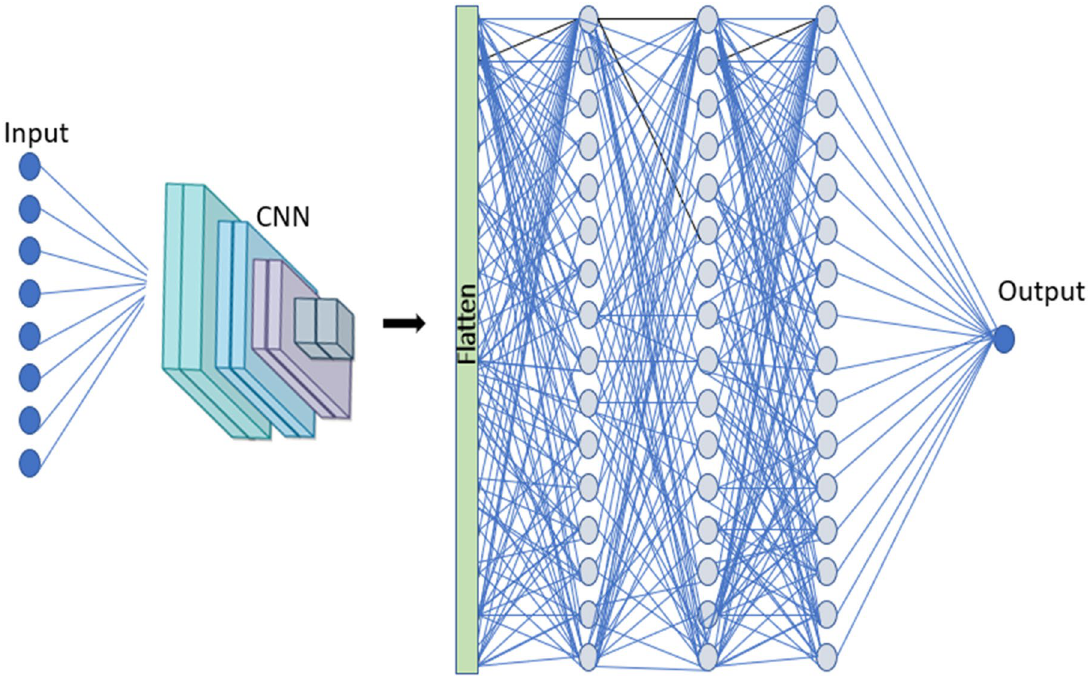
Figure 6. Hybrid CNN-ANN